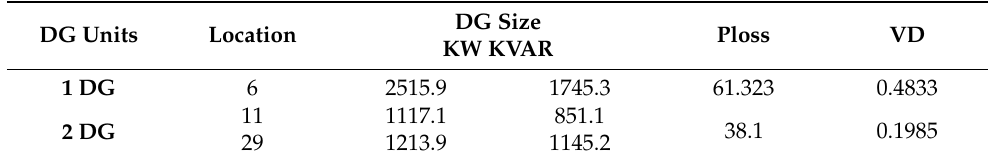
Table 17. Case 4: optimal DG III allocation based on loss minimization.